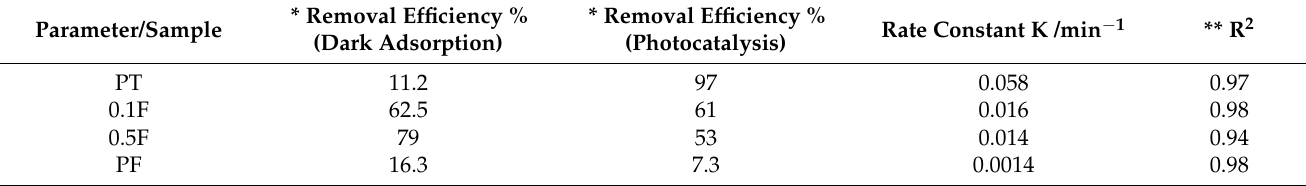
Table 4. Photocatalytic degradation